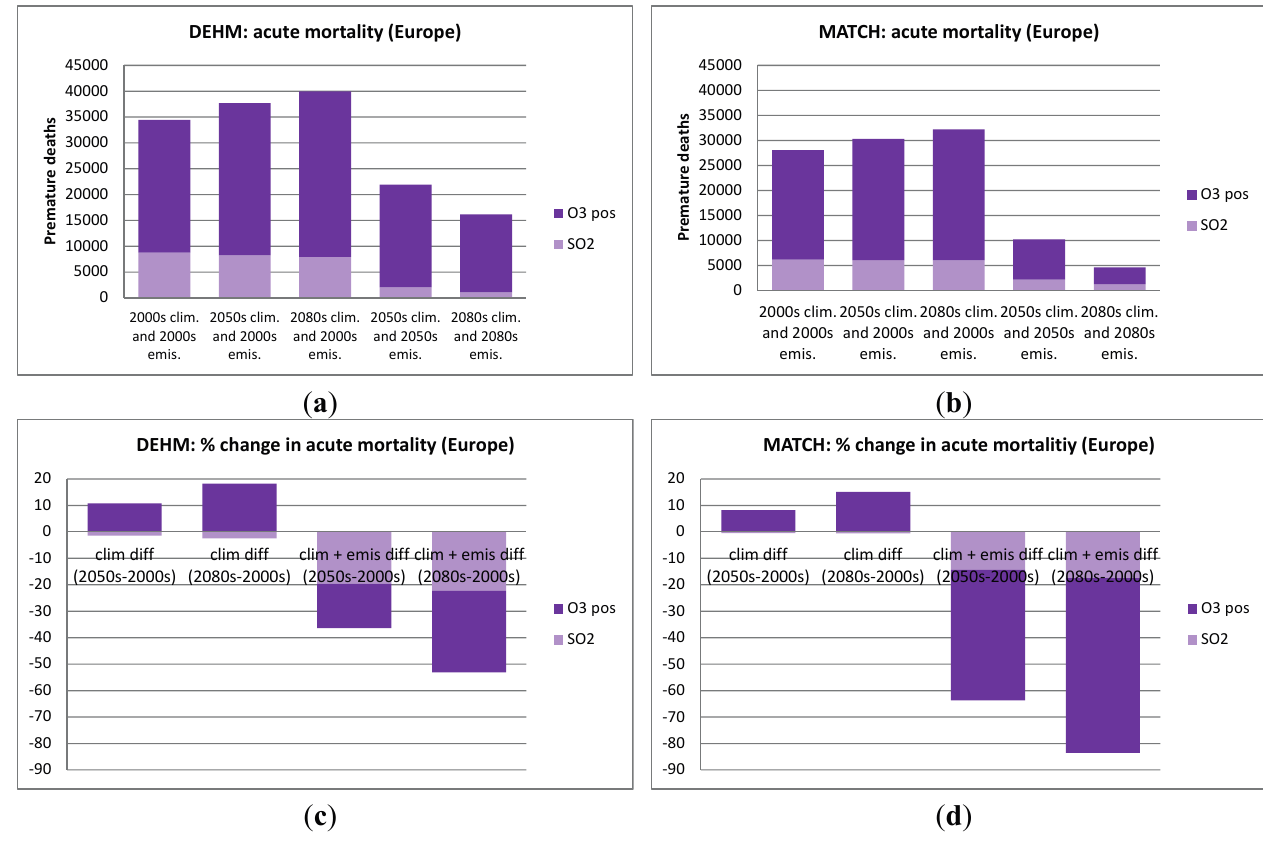
Figure 4. Acute mortality as estimated by DEHM (left) and MATCH (right) for the European region. In ( a ) and ( b ) the first three columns show the number of premature deaths in the 2000s, the 2050s and 2080s, when only changing the climate. The last two columns includes both climate and emissions changes for the 2050s and the 2080s; In ( c ) and ( d ) the change in % relative to the 2000s are